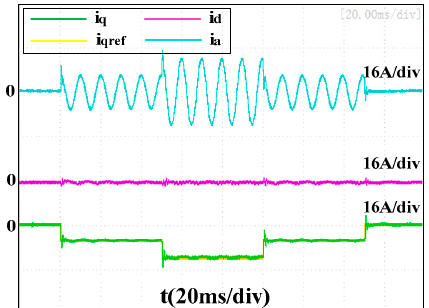
Figure 15. d-q axis current waveform of the conventional current controller with feedback decoupling at 6000 rpm with Kp = 1000 π Ls. Figure 16. d-q axis current waveform of the proposed accurate discrete current controller at 6000 rpm with Kdq = 1000 π Ls.